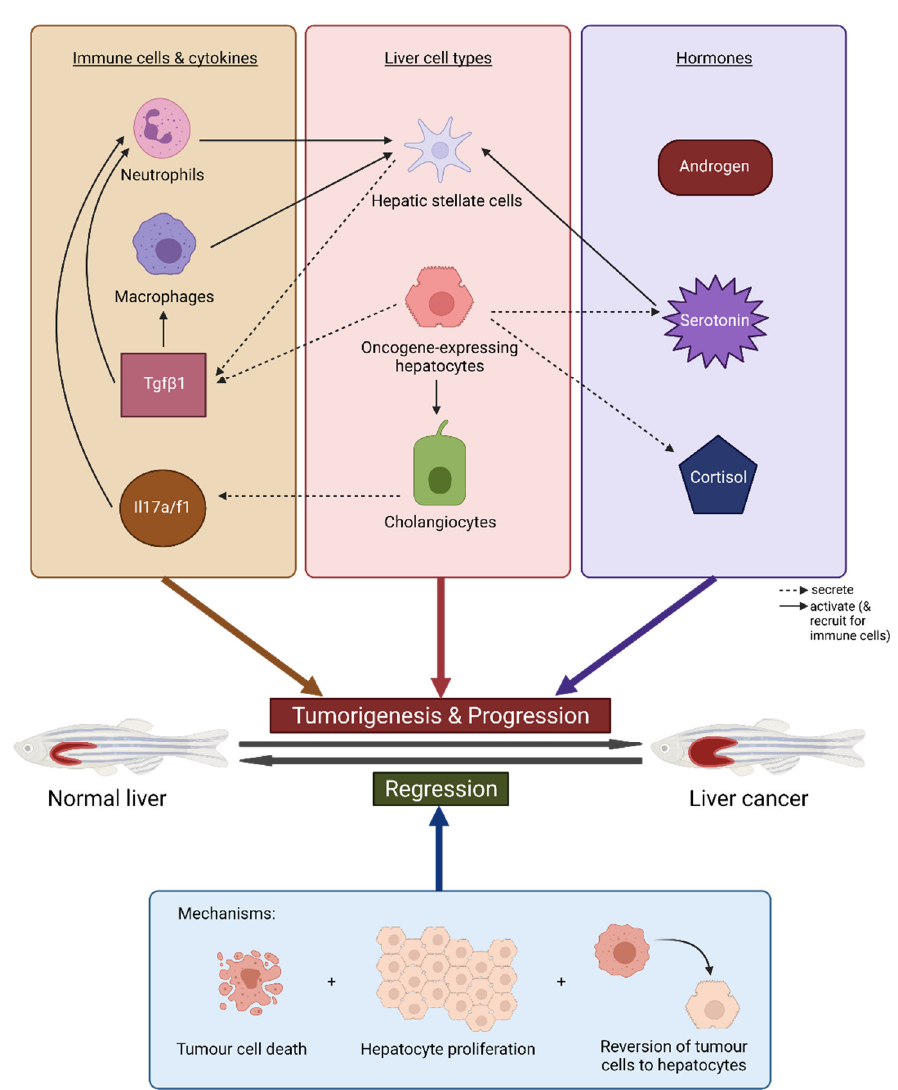
Figure 2. Summary of key pathways and mechanisms involved in tumour development and regression in our transgenic zebrafish models of liver cancer. The figure displays the main liver cells (hepatocytes and cholangiocytes) and immune cell types, cytokines and hormones that contribute to or exacerbate tumorigenesis and progression to liver cancer, and the crosstalk between them. The three mechanisms for tumour regression are also shown. Figure created with BioRender.com (accessed on 17 August 2021).